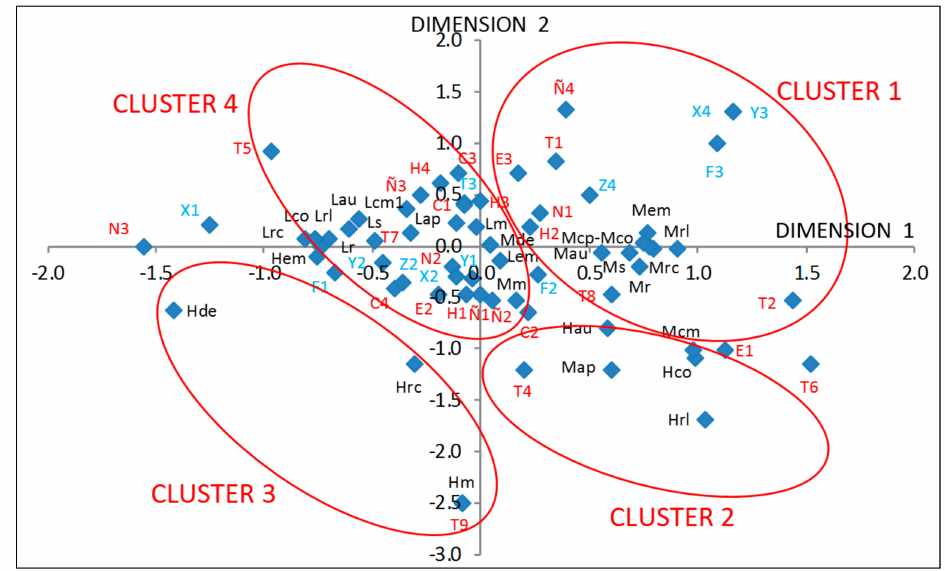
Figure 1. Factorial plane of the variable category relationships studied in the multiple correspondence analysis (see nomenclature in Tables A4 and A5 (Appendix